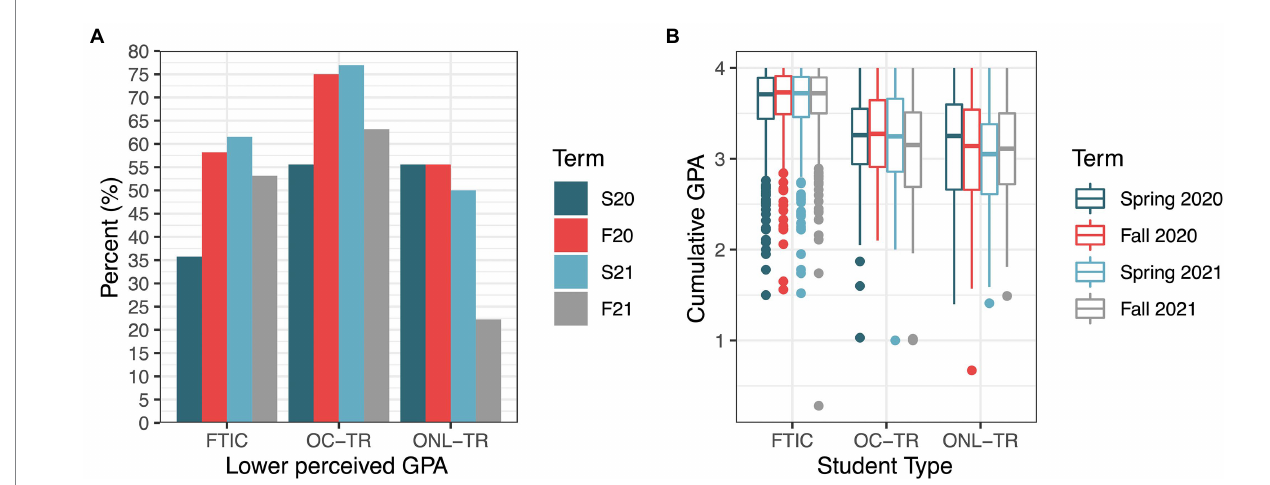
FIGURE 2 Perceptions of lower GPA were greatest at the height of the pandemic (fall 2020 and spring 2021) but could not be validated by academic records. (A) The percentage of respondents that perceived a lower GPA (53% of 482 responses) during the pandemic by student type and term. However, (B) no differences were observed in entering cumulative GPA for all enrollments across spring 2020, fall 2020, spring 2021, and fall 2021 terms separated by student type.